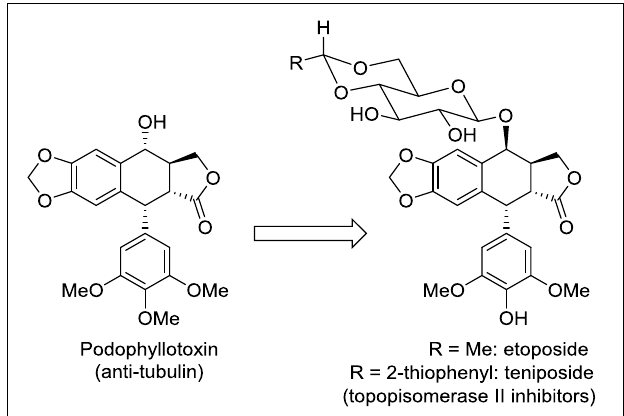
FIGURE 1 | Structures of podophyllotoxin, etoposide, and teniposide.